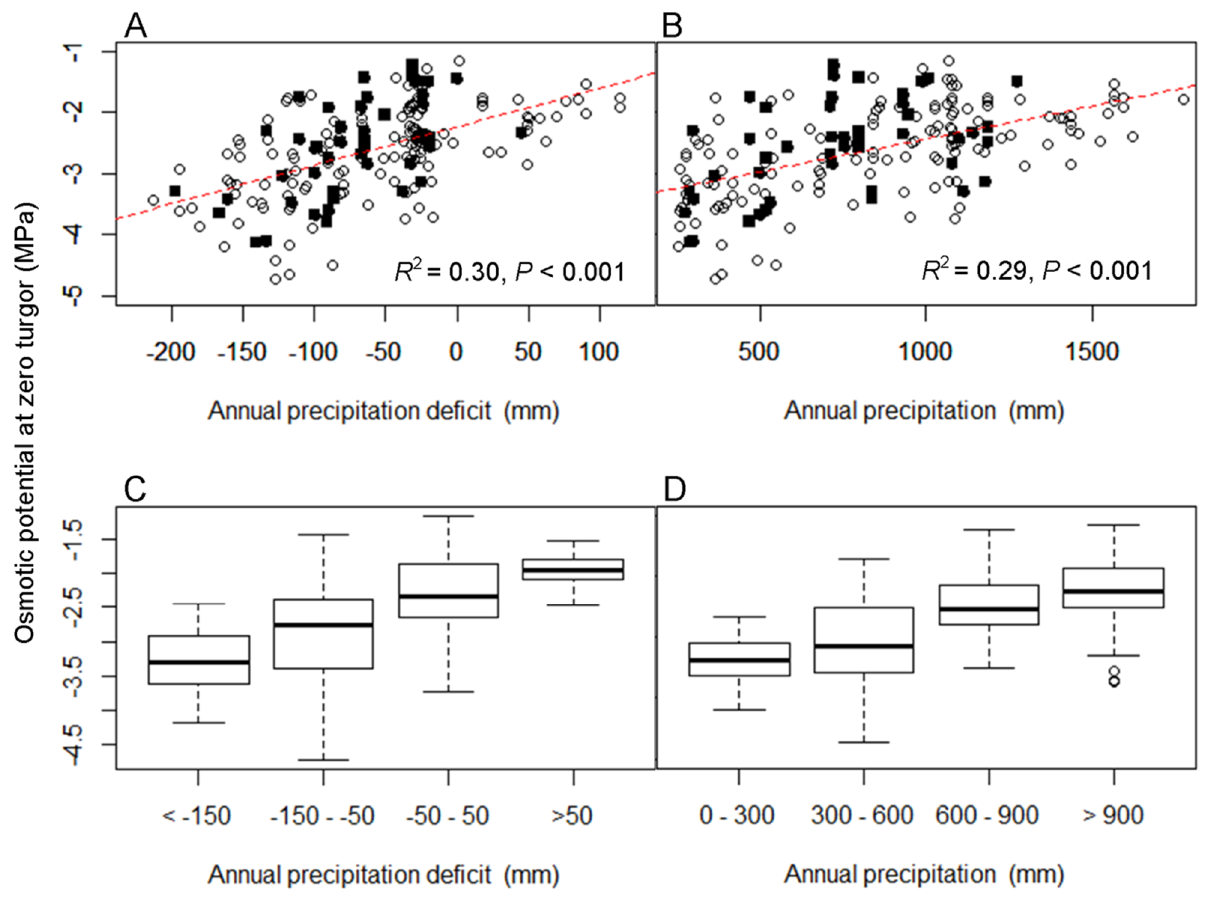
Figure 2. Relationship between species climatic water availability and osmotic potential at zero turgor for all species in the database ( n = 174). Scatter plot of ( A ) mean annual precipitation deficit ( R 2 = 0.30, p < 0.001) and ( B ) mean annual precipitation versus osmotic potential at zero turgor ( R 2 = 0.29, p < 0.001) and box (spanning the 25th to 75th percentiles and bold line at the median) and whiskers (spanning the 5th to 95th percentiles) of binned data for ( C ) mean annual precipitation deficit and ( D ) mean annual precipitation. ( A ) and ( B ) are fitted with linear regression (red dashed line) see Table 1 for details. The solid square symbols in ( A ) and ( B ) represent values for Eucalyptus spp. ( n = 47). While MAP and MAPD were the best single predictors of π tlp , using an interaction term between MAPD and MHMT (at 0.98 percentile) improved the fit to the data (Figure 3; R 2 = 0.35, p < 0.001). Species climate envelopes that included extremely high summer temperatures (MHMT > 35 °C) tended to have more negative π tlp than those species with cooler summer maximum temperatures (Figure